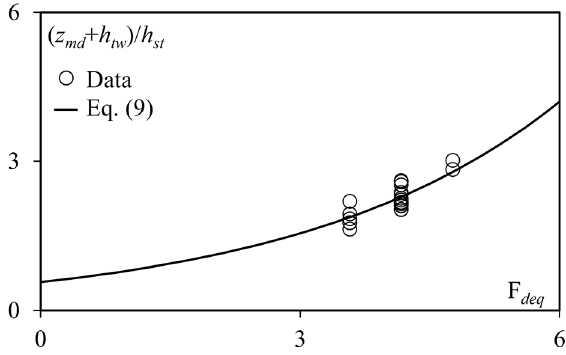
Figure 11. ( z md + h tw )/ h st vs F deq along with the plot of Equation (9).